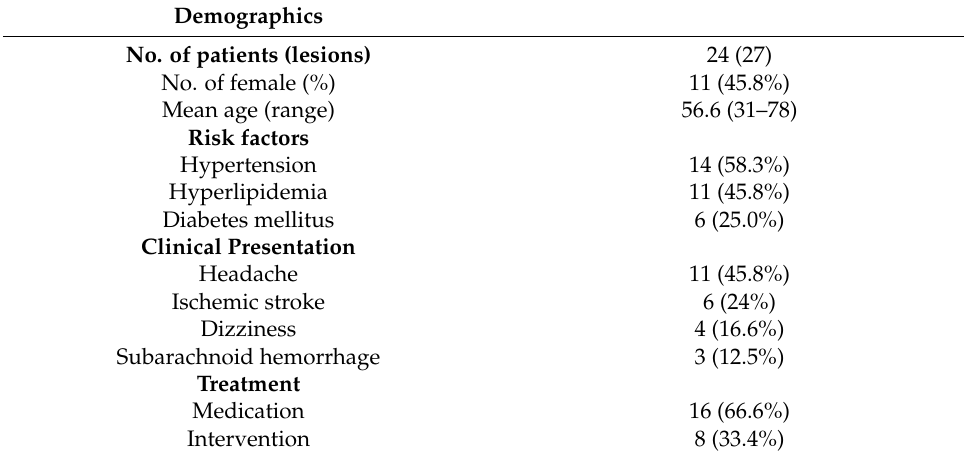
Table 2. Clinical characteristics of study